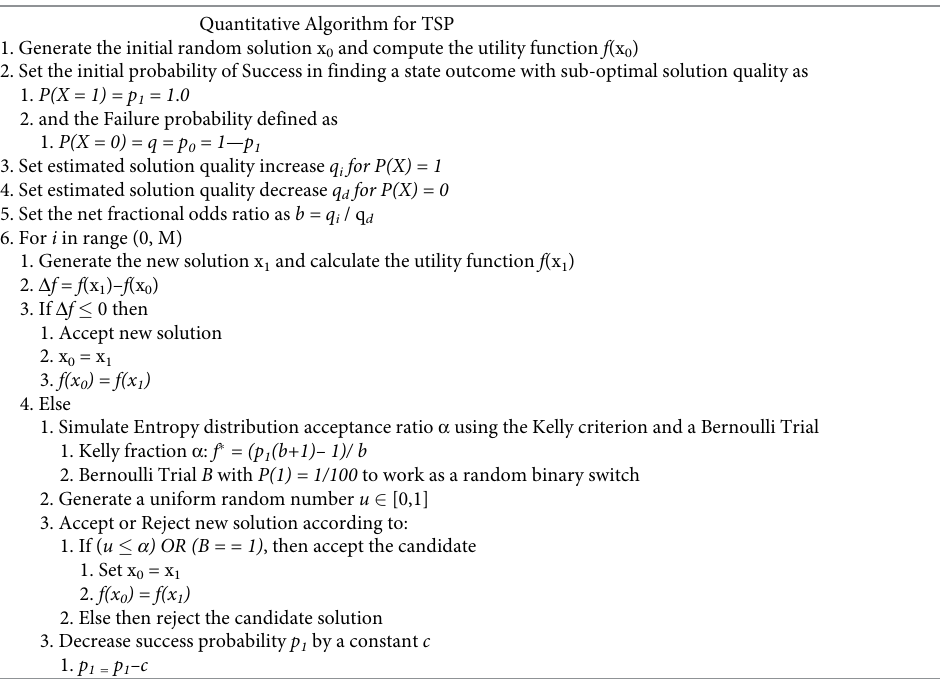
Table 7. Proposed pseudo-code algorithm to solve the TSP.